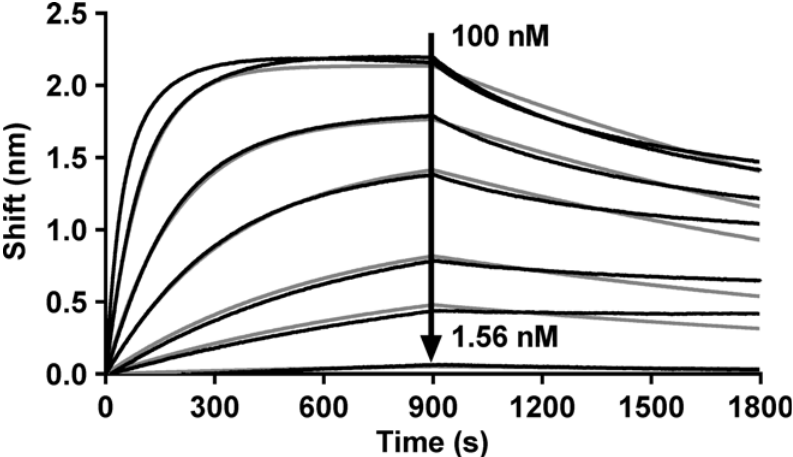
Fig 4. Affinity measurement of the Nanofitin D8 against StrepTagII-GFP. Kinetic characterization of StrepTagII-GFP – Anti-GFP Nanofitin D8 interaction, measured by interferometry. Black curves represent experimental data and grey curves represent the statistical fitting of the curves.